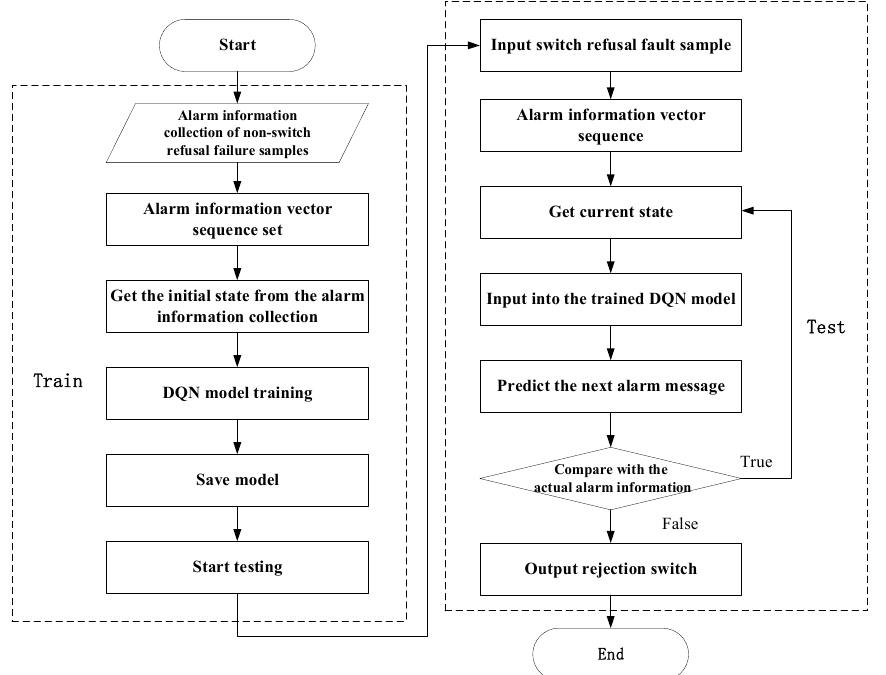
Figure 3. Flowchart of grid fault diagnosis based on DQN.